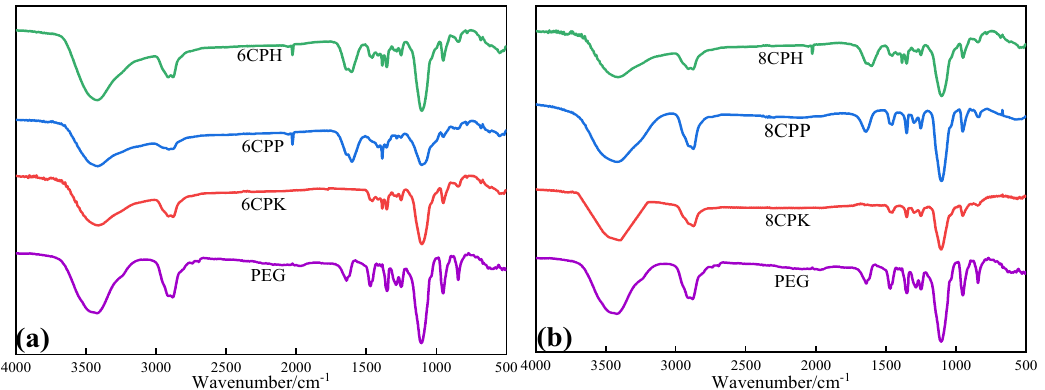
Figure 2. Infrared spectra of the composites and pure PEG under different temperature activation. ( a ) FTIR of PEG and the composites after activation at 600 °C; ( b ) FTIR of PEG and the composites after activation at 800 °C.